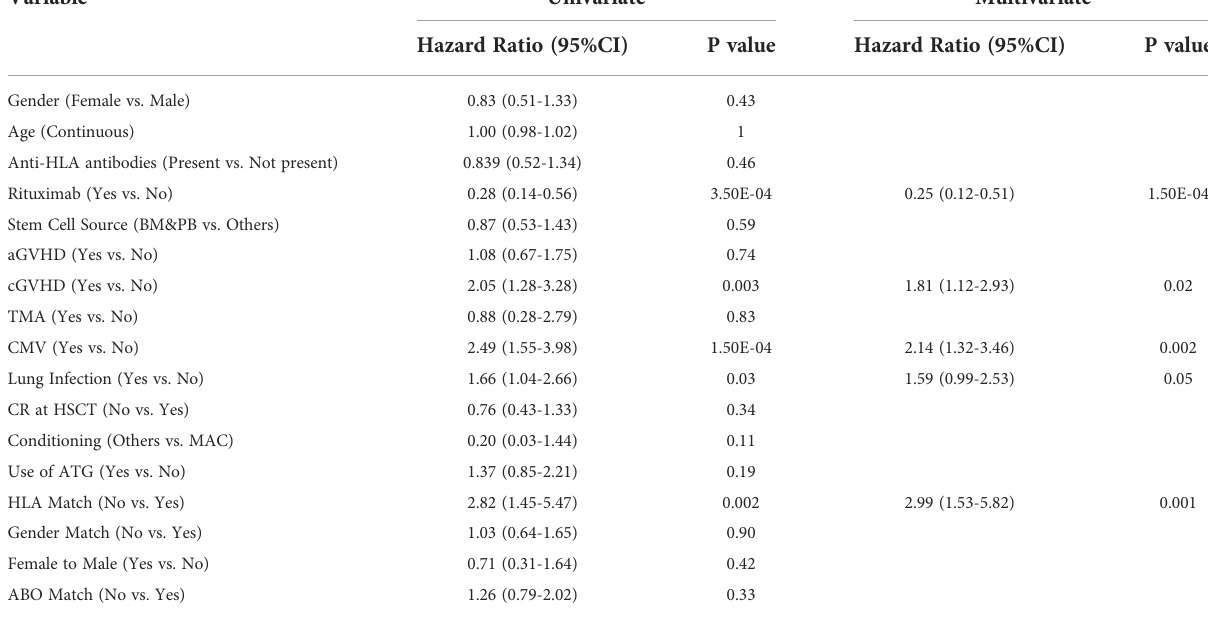
TABLE 3 Risk factors for EBV reactivation in entire patient